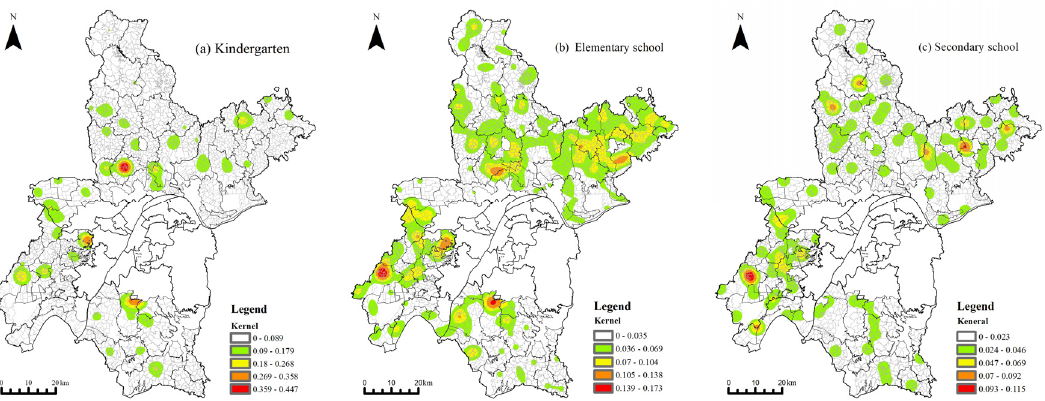
Figure Figure 3. Kernel density analysis of rural basic education resources in Wuhan City’s new urban districts.